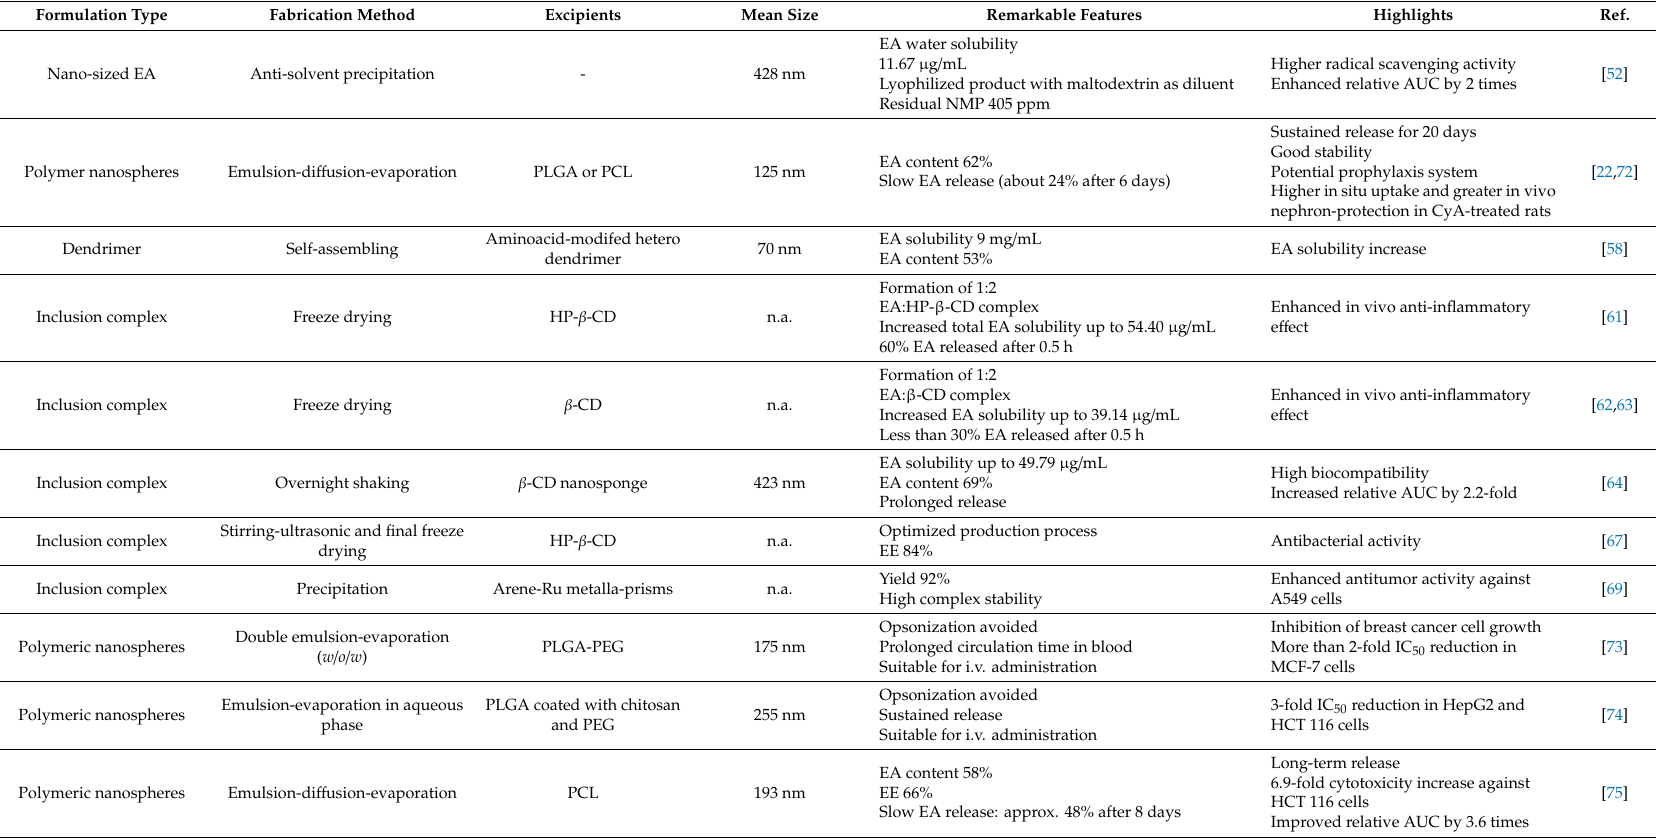
Table 3. EA nano-sized formulations and their distinctive